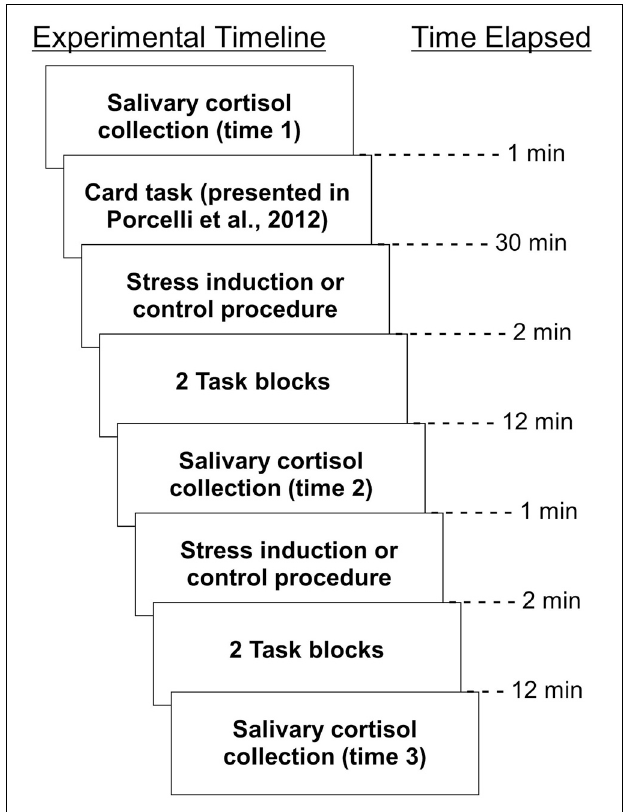
FIGURE 1 | Timeline of experimental activities. All procedures, as well as time elapsed between them, are